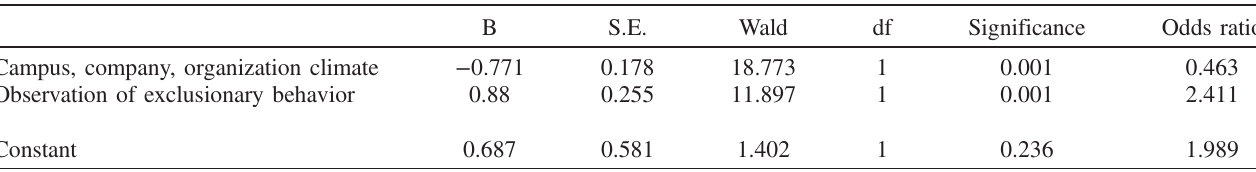
TABLE II. Reduced model with only significant variables